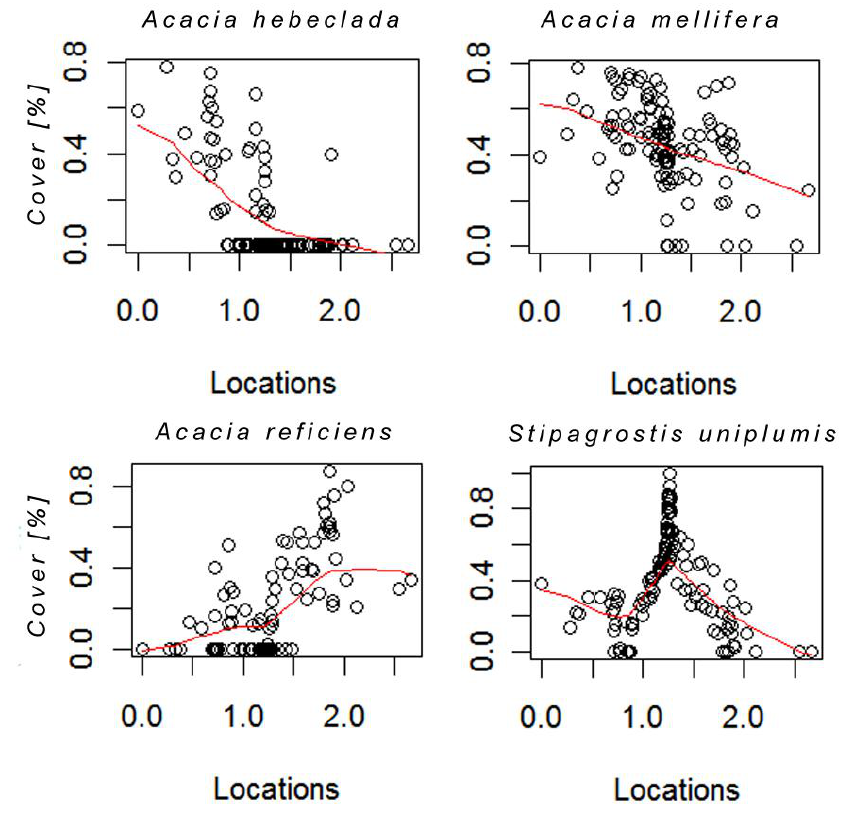
Figure 4. Hellinger transformed cover values of four dominant species plotted for each location on the curve. The red line represents the smoothing spline used to fit the individual response